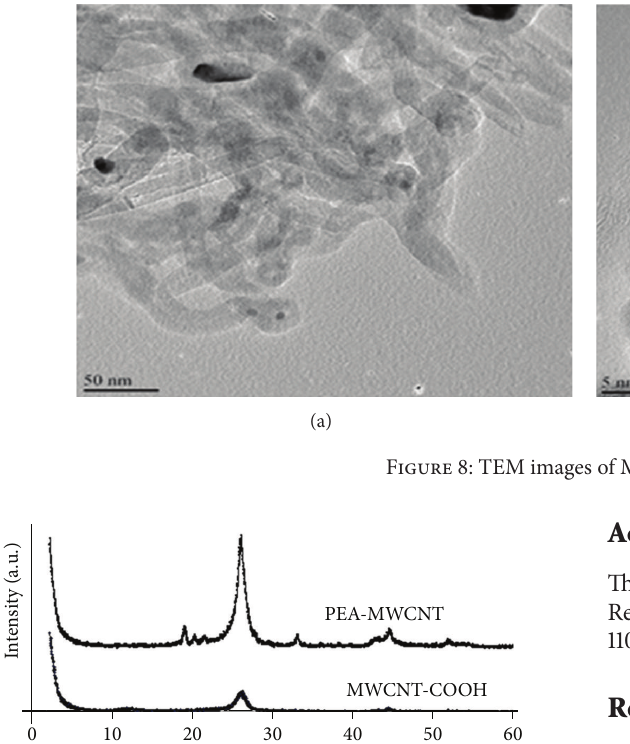
prevent the agglomeration of MWCNT layers. The morpho- logical structures of composites have been confirmed by SEM